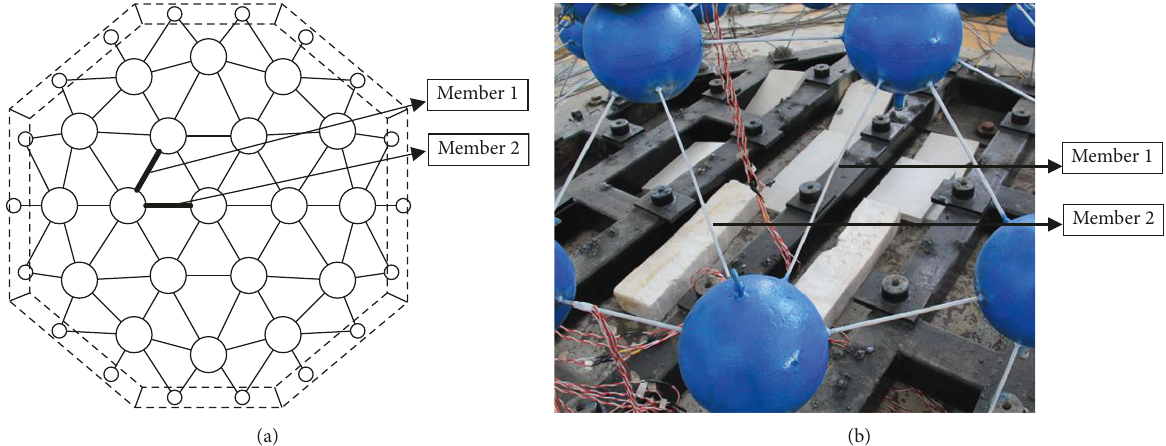
Figure 11: The damaged members in the structure without isolated support under Taft motion with amplitude of 700cm/s 2 . (a) The position of the damage members; (b) damage members in the tested